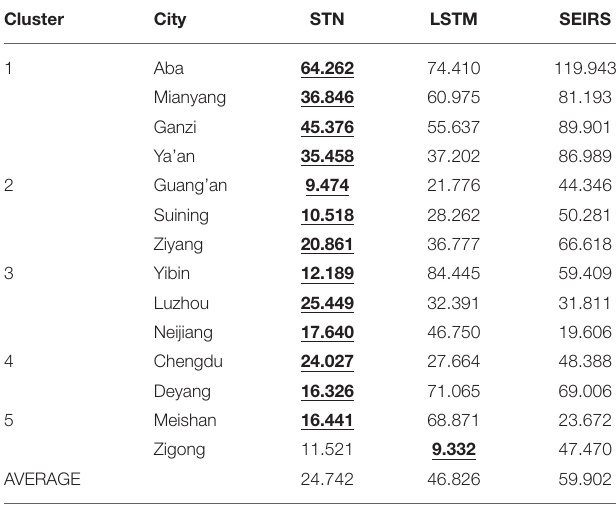
The minimum MAPE value of the three methods for each city is indicated in bold and underlined in the table.